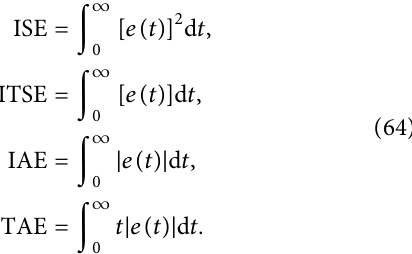
Figure 15: Te stability region of the antenna ( ω